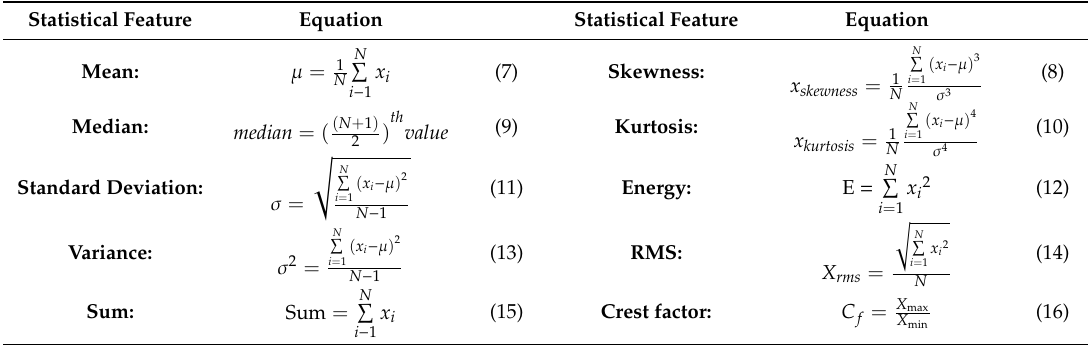
Table 3. Extracted statistical features from time domains for the feature matrix (x is the current signal). Statistical